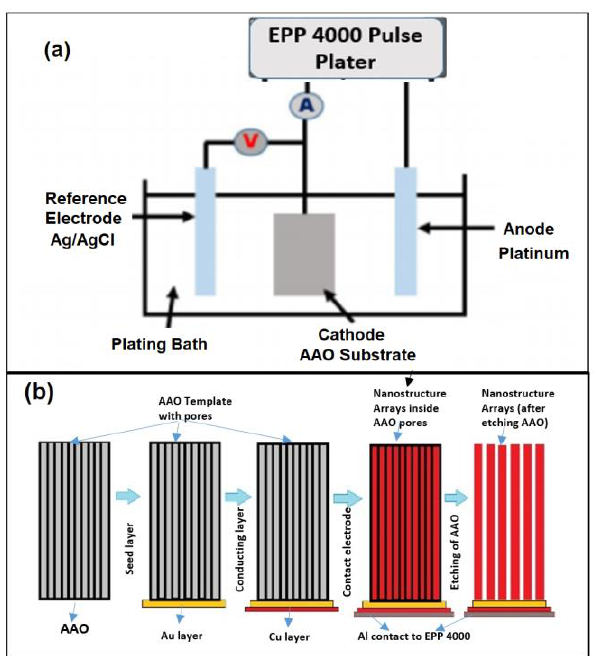
Figure 1. ( a ) Pulse plating experimental set up and ( b ) schematic illustration for template assisted